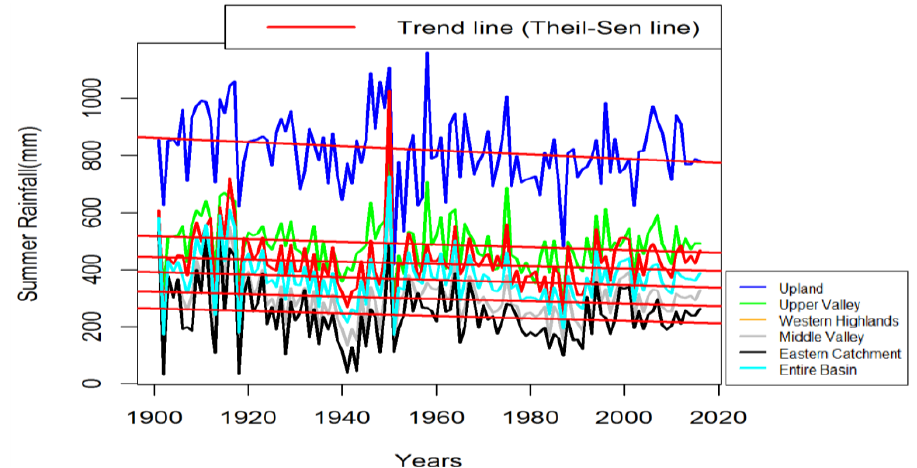
Figure 10. Summer rainfall time series showing significant decreasing trends for the period 1900 – 2016. Table 4. Summary trend analysis for summer